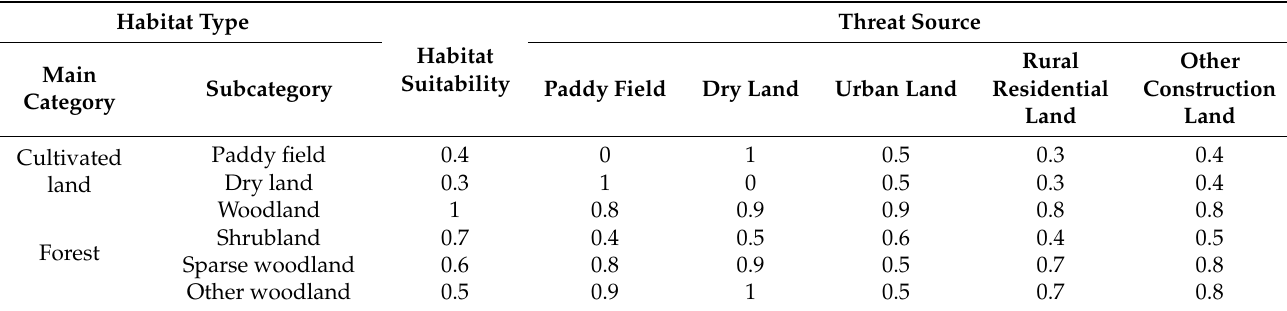
Table A2. Habitat types and sensitivity of habitat types to each